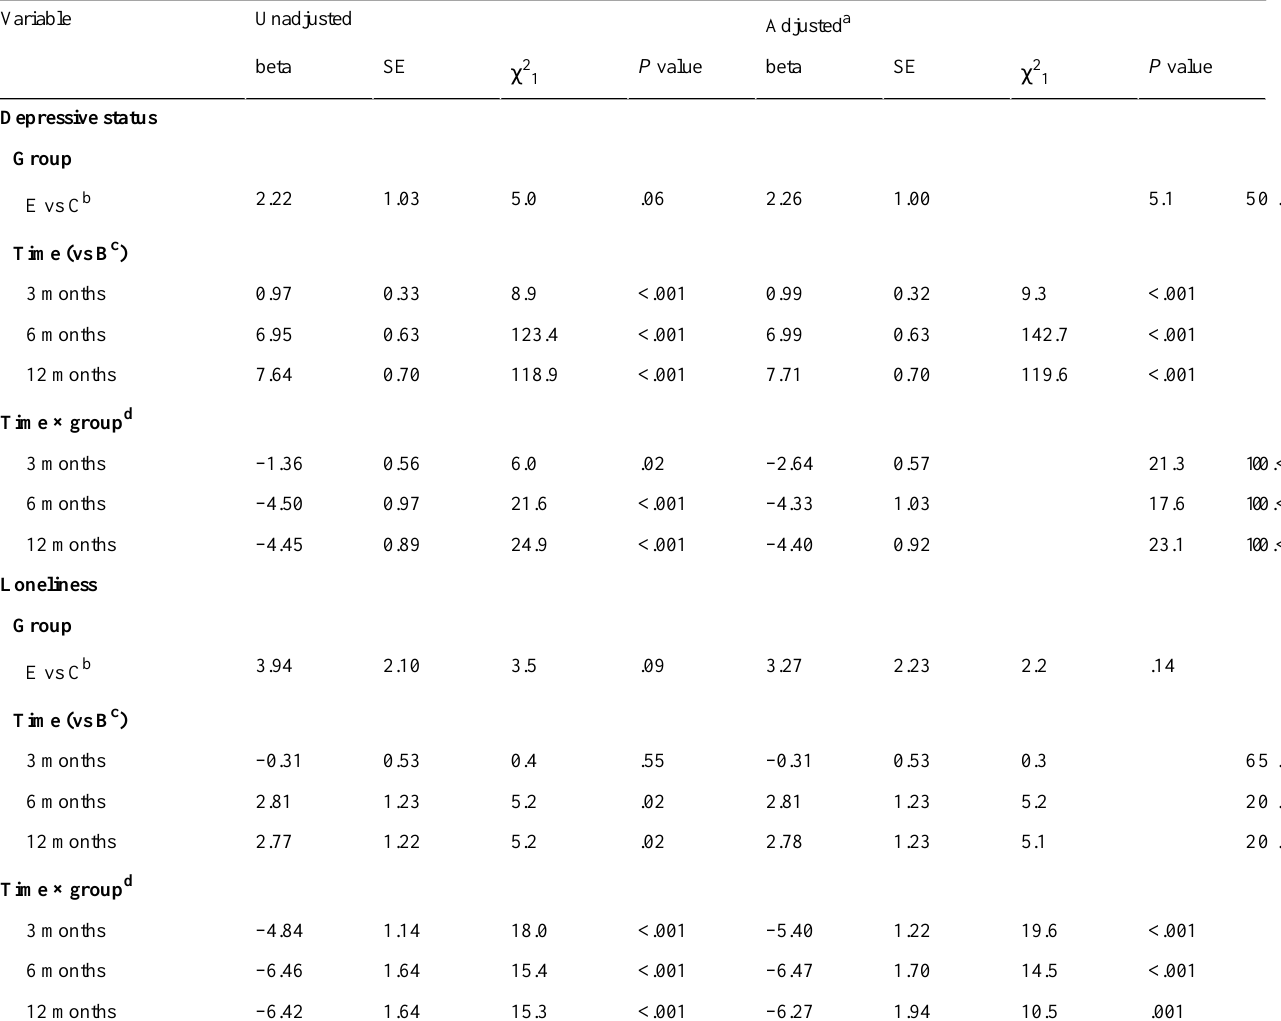
Table 3. Effects of videoconference intervention on participants’ depressive status and loneliness at 3, 6, and 12 months in consideration of group, time, and time × group